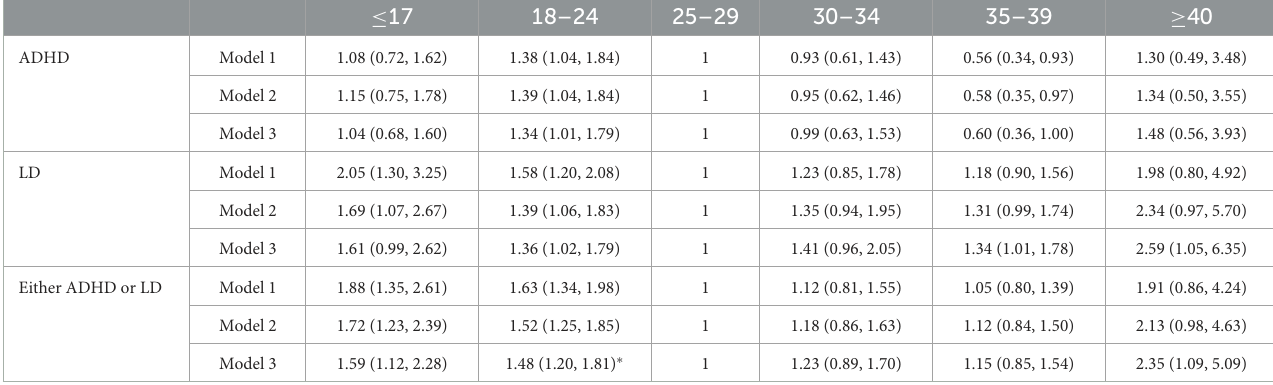
TABLE 3 Association between maternal age at childbirth and parent-reported LD, ADHD, and either LD or ADHD. ≤